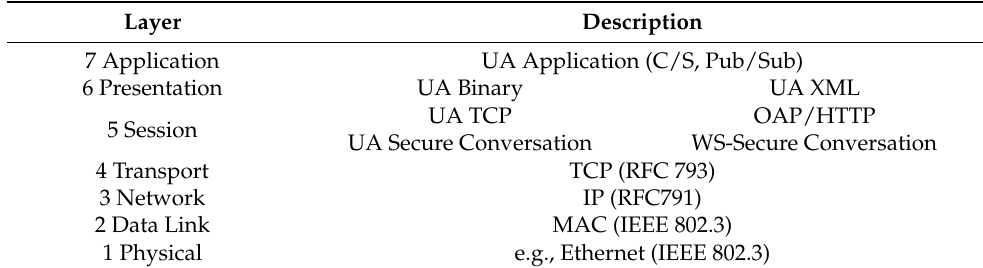
Table 1. The OPC UA ISO/OSI model.